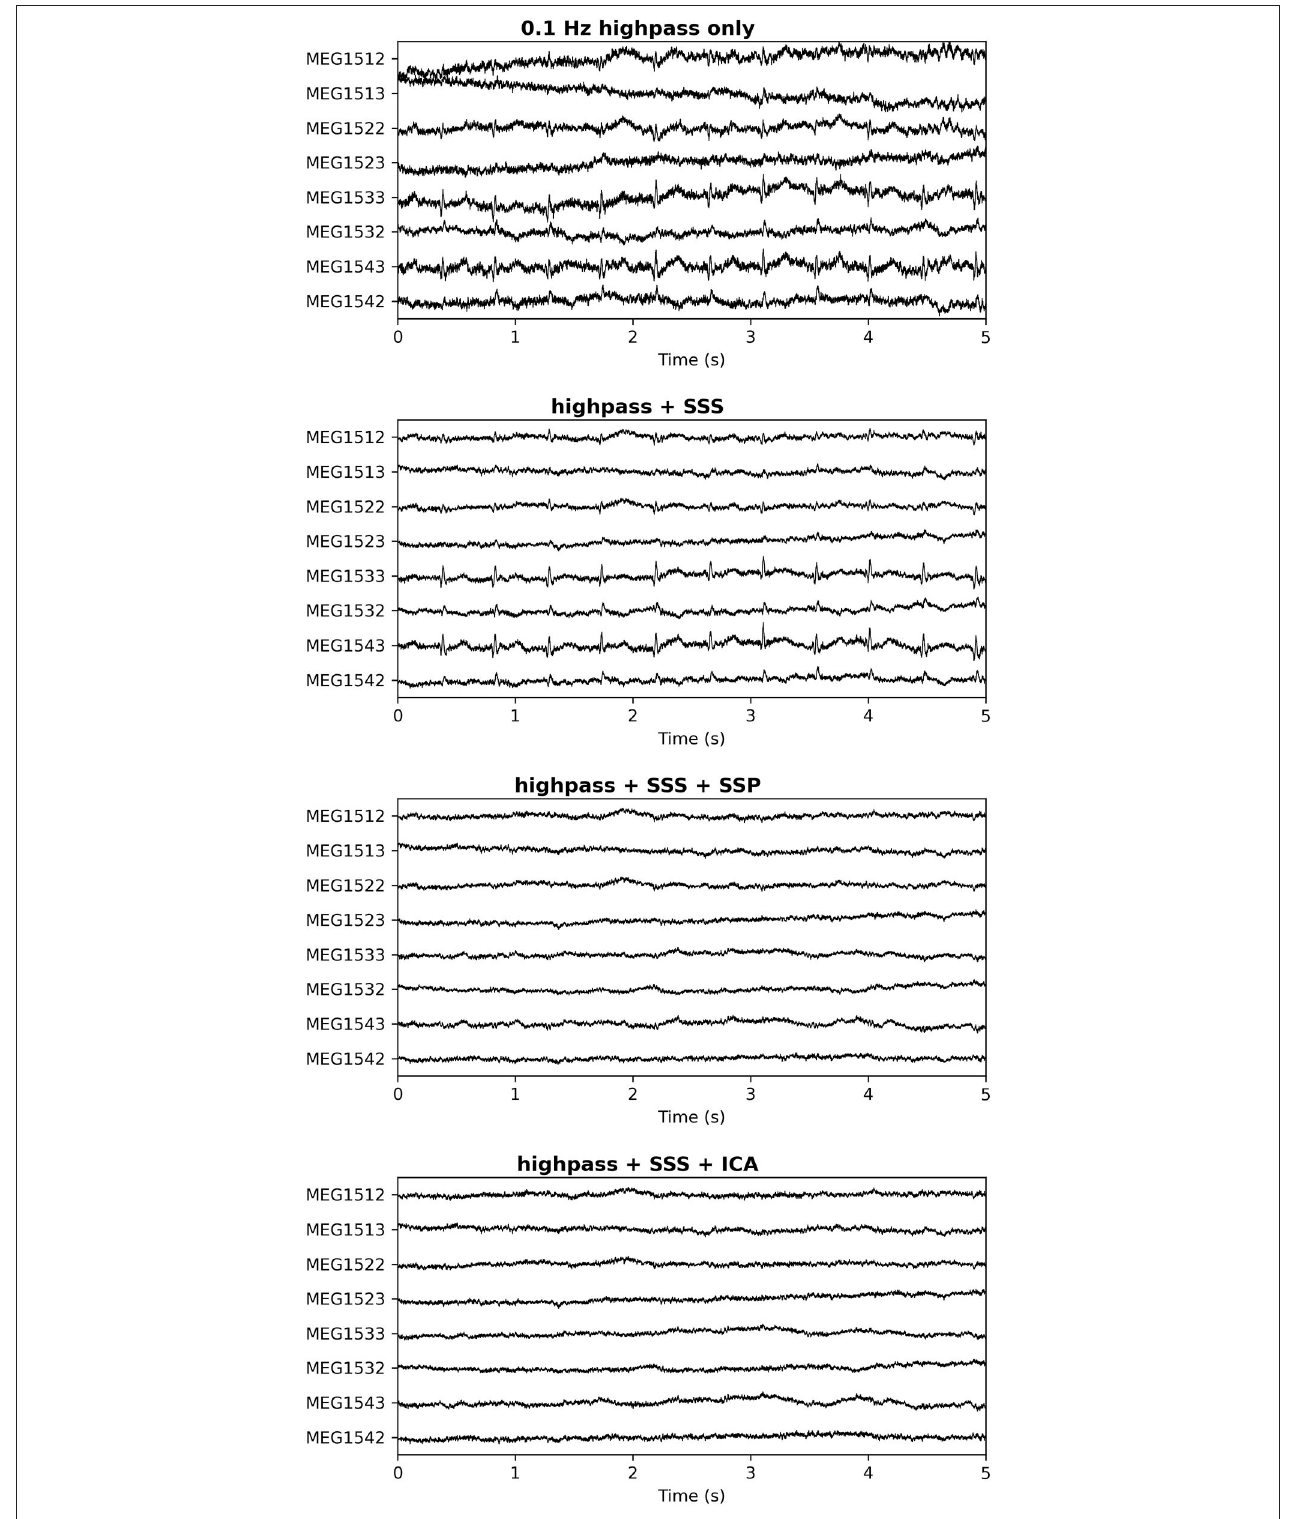
FIGURE 6 | Cardiac artifact on a subset of channels after different pre-processing approaches. Top: No processing; Second Panel: SSS only; Third Panel: SSS followed by SSP (2 orthogonal projectors); Bottom Panel: SSS followed by ICA (4 cardiac-related latent sources removed). In the third and bottom panels the cardiac artifacts have been successfully repaired. The spatial distribution of the cardiac artifact stays virtually intact in the SSS process, indicating that most of its signal energy comes from the internal SSS volume where the head is located.